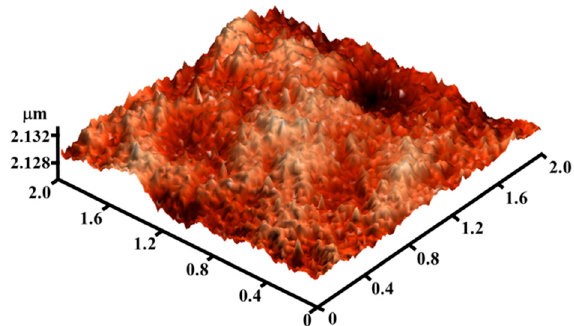
Figure 3. AFM images of dielectric layer exhibiting a smooth surface that could avoid electron trapping at the insulator-channel interface.